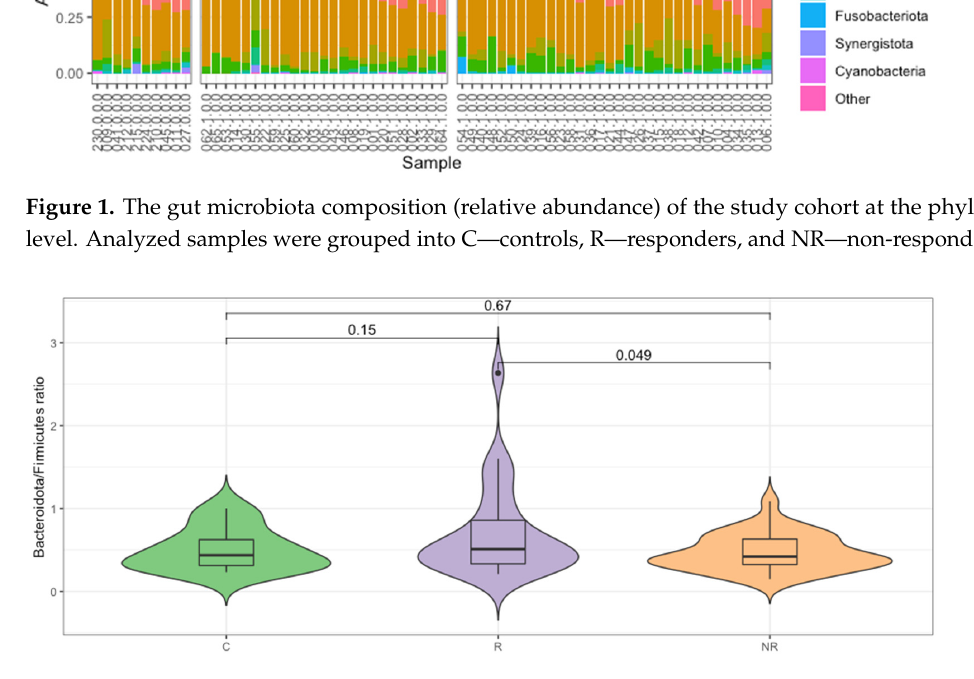
Figure 2. Bacteroidota/Firmicutes ratio differs significantly ( p < 0.05, t -test) for the responder (R) and non-responder (NR) groups.